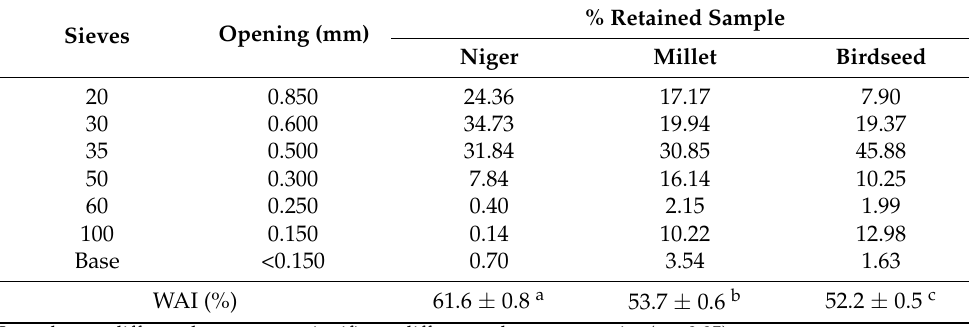
Table 2. Granulometry and water absorption index (IAA) of the flour seeds